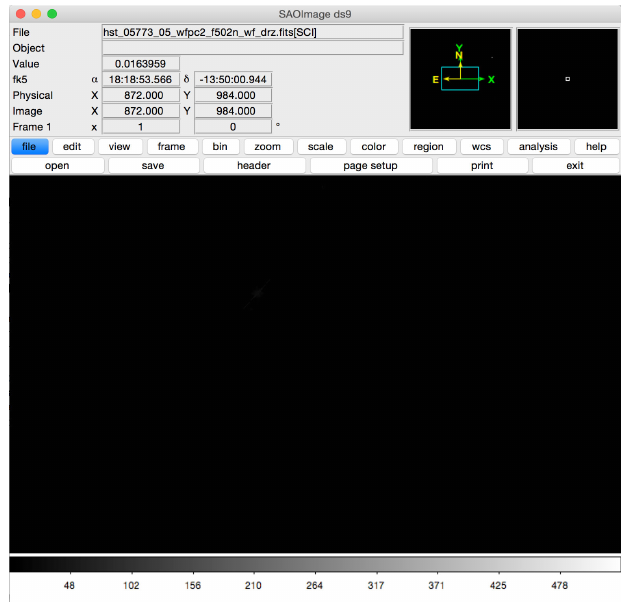
Fig. 35.— Opening an HST Eagle Nebula image in